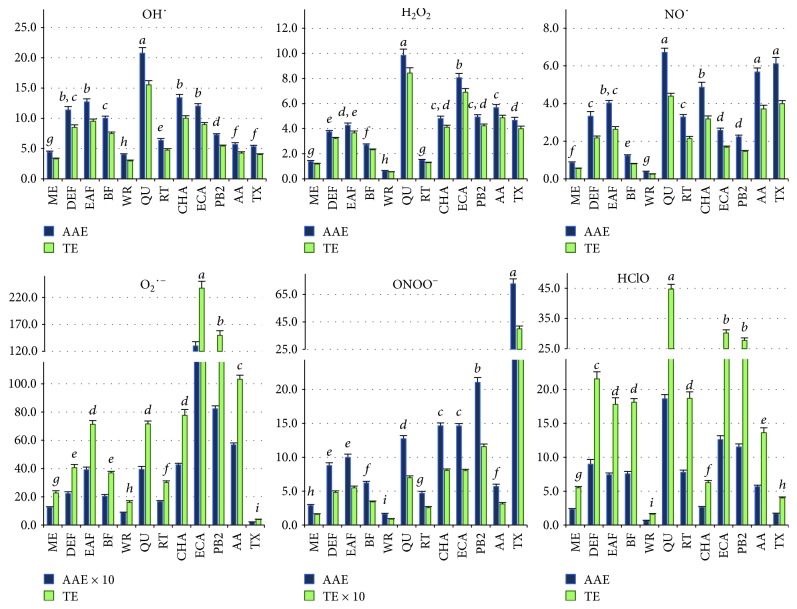
Scavenging activity of the S. aucuparia flower extracts, model polyphenols, and standard antioxidants on six different biologically relevant oxidants, expressed in equivalents of AA (mmol AAE/g dw) and TX (mmol TE/g dw). Values on particular charts labelled with the same italics (a-i) did not differ significantly at α = 0.05.